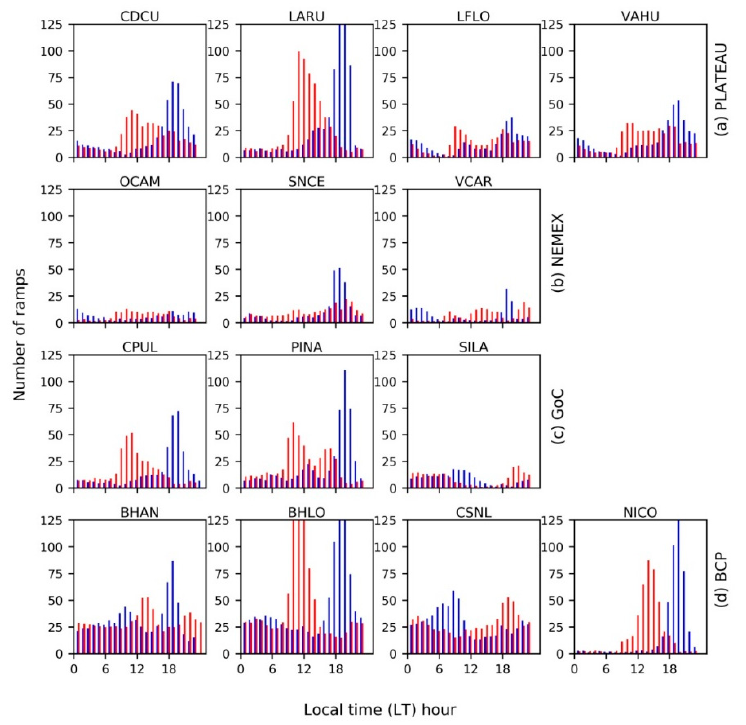
Figure 5. Hourly distribution of annual mean wind power ramp-up (red) and ramp-down (blue) events for ( a ) Plateau, ( b ) NEMEX, ( c ) GoC, ( d ) BCP regions.